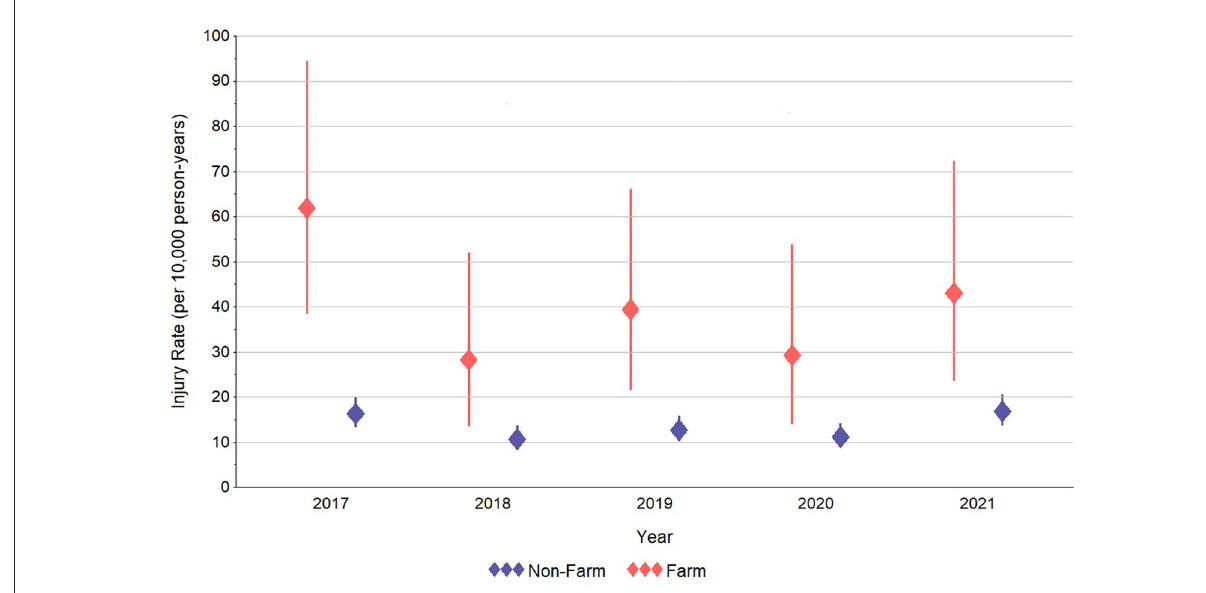
FIGURE2 Estimated annual incidence rate of farm-related injuries in north-central Wisconsin children and adolescents who did and did not live on a farm in